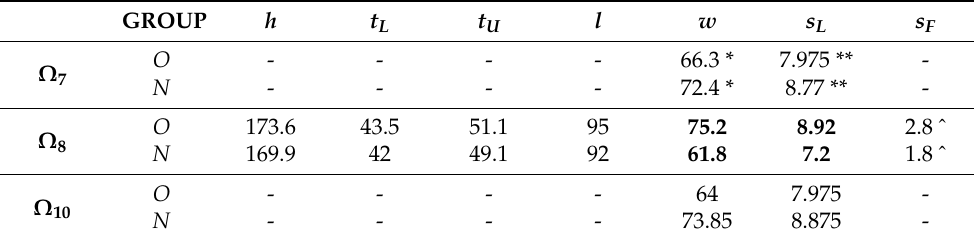
Table 5. Median values of the body components for observation and no observation groups of Ω 7 , Ω Ω < 0.05 (unless indicated otherwise) based on the Wilcoxon rank 8 , and 10 with significance p sum test.